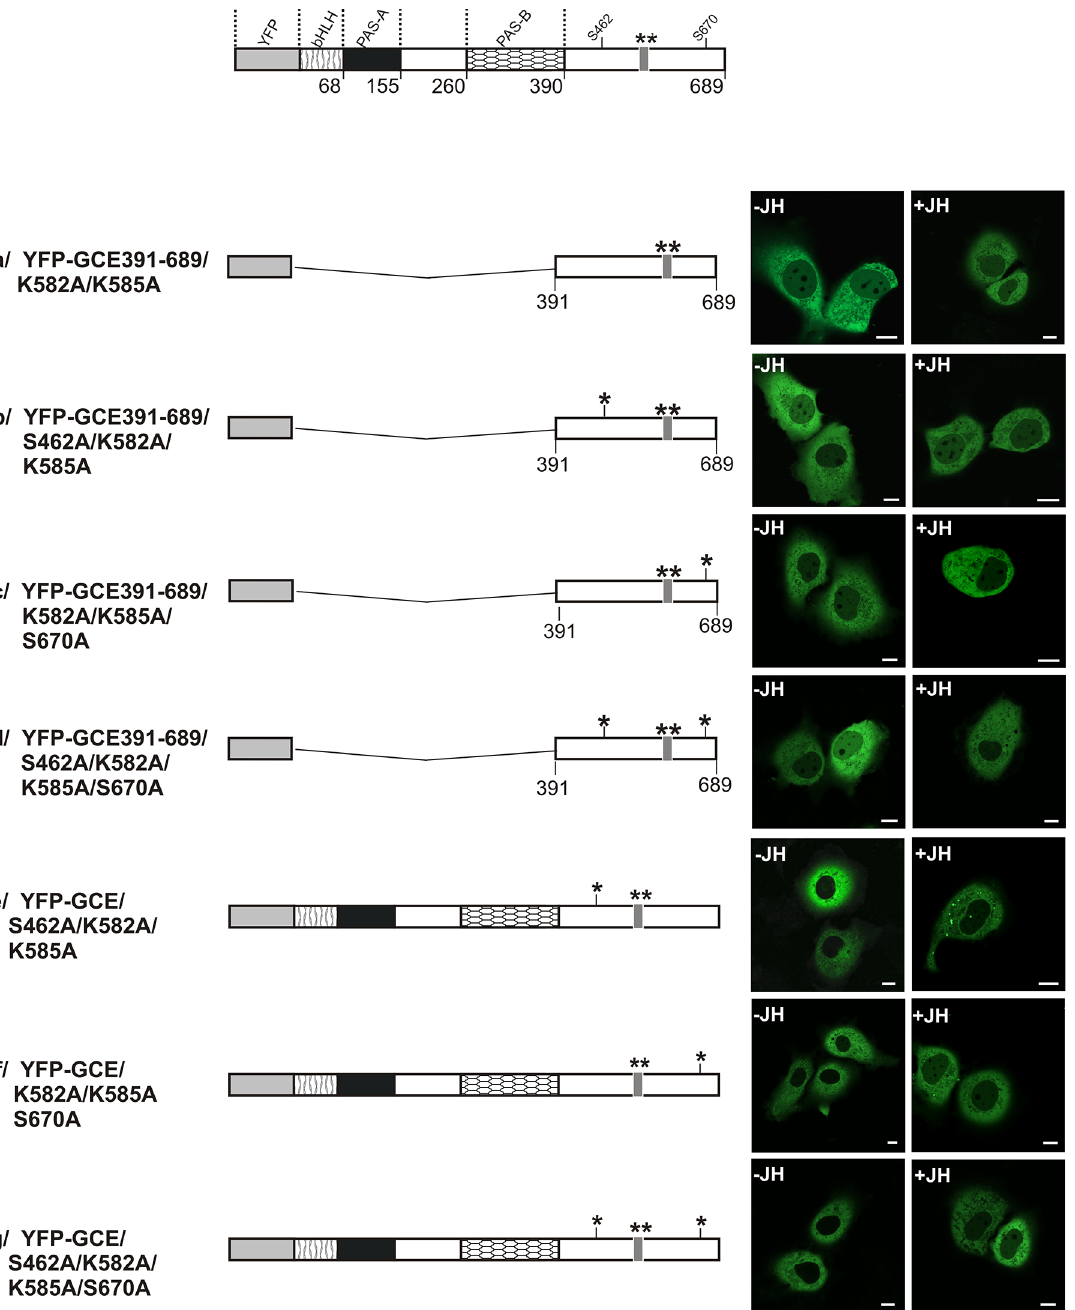
Fig 5. Subcellular distribution of the S462A and/or S670A GCE mutants with disabled C-terminal NLS. The influence of JH on the subcellular distribution of the S463A and/or S670A with deactivated NLS of mutants encompassing C-terminus or full length GCE was analysed. The subcellular localization of the expressed proteins tagged with YFP was analyzed by confocal microscopy 20-24h after the transfection of COS-7 cells in the absence and presence of JH. The length of each domain in protein schematic illustration is arbitrary. Regions of GCE are depicted using different patterns. Asterisks indicate mutated residues. Representative images (single confocal plane) present the typical subcellular distribution of the GCE derivatives. Bar, 10 μ